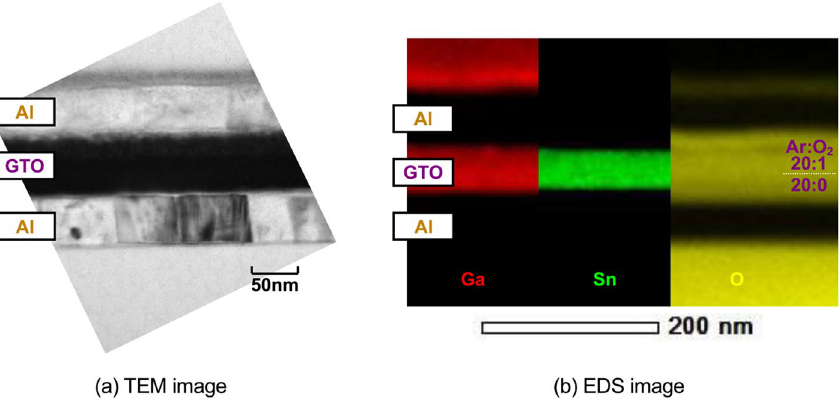
Figure 2. Cross-sectional image ( a ) TEM image. ( b ) EDS image. It is found that the cross section shown in Fig. 1b is certainly